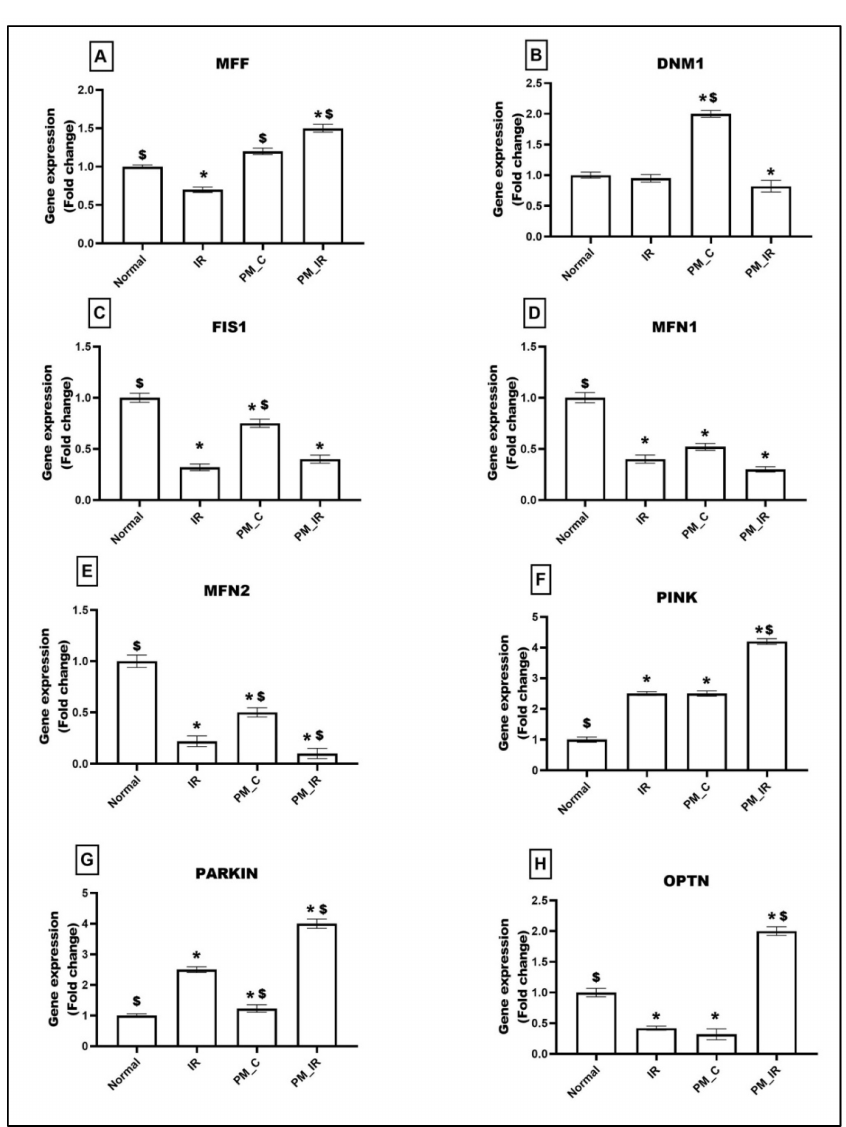
Figure 3. mRNA expression changes of ( A ) MFF, ( B ) DNM1, ( C ) FIS1, ( D ) MFN1, ( E ) MFN2, ( F ) PINK, ( G ) PARKIN, and ( H ) OPTN in myocardium. Values are mean ± SD. Significant dif- ference from control group is indicated by asterisk (* p < 0.05, $ p < 0.05 vs. IR control). [Groups: (1) Normal, (2) IR, (3) PM_C, (4)